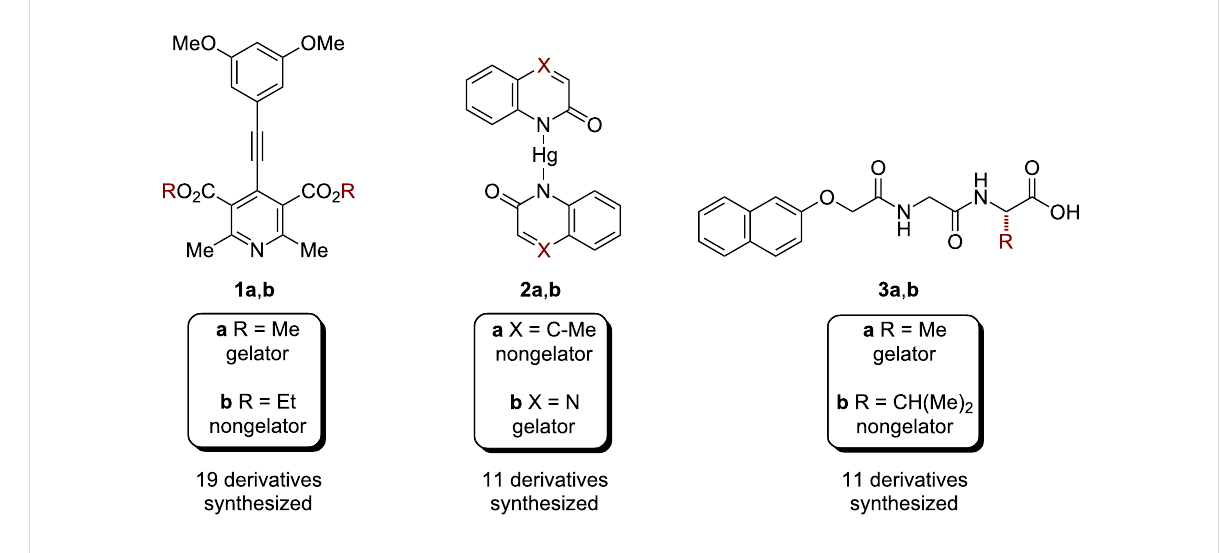
Figure 3: Examples of structurally similar gelators and nongelators examined in our studies.